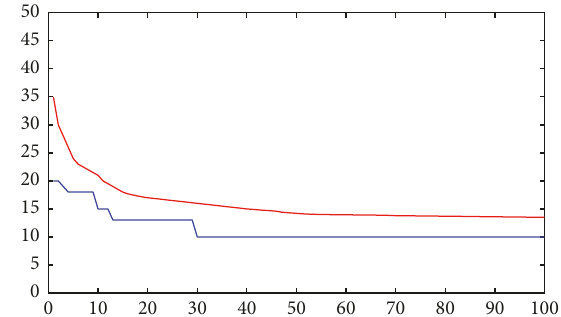
Figure 10: Evolutionary curve obtained by random initializing method.